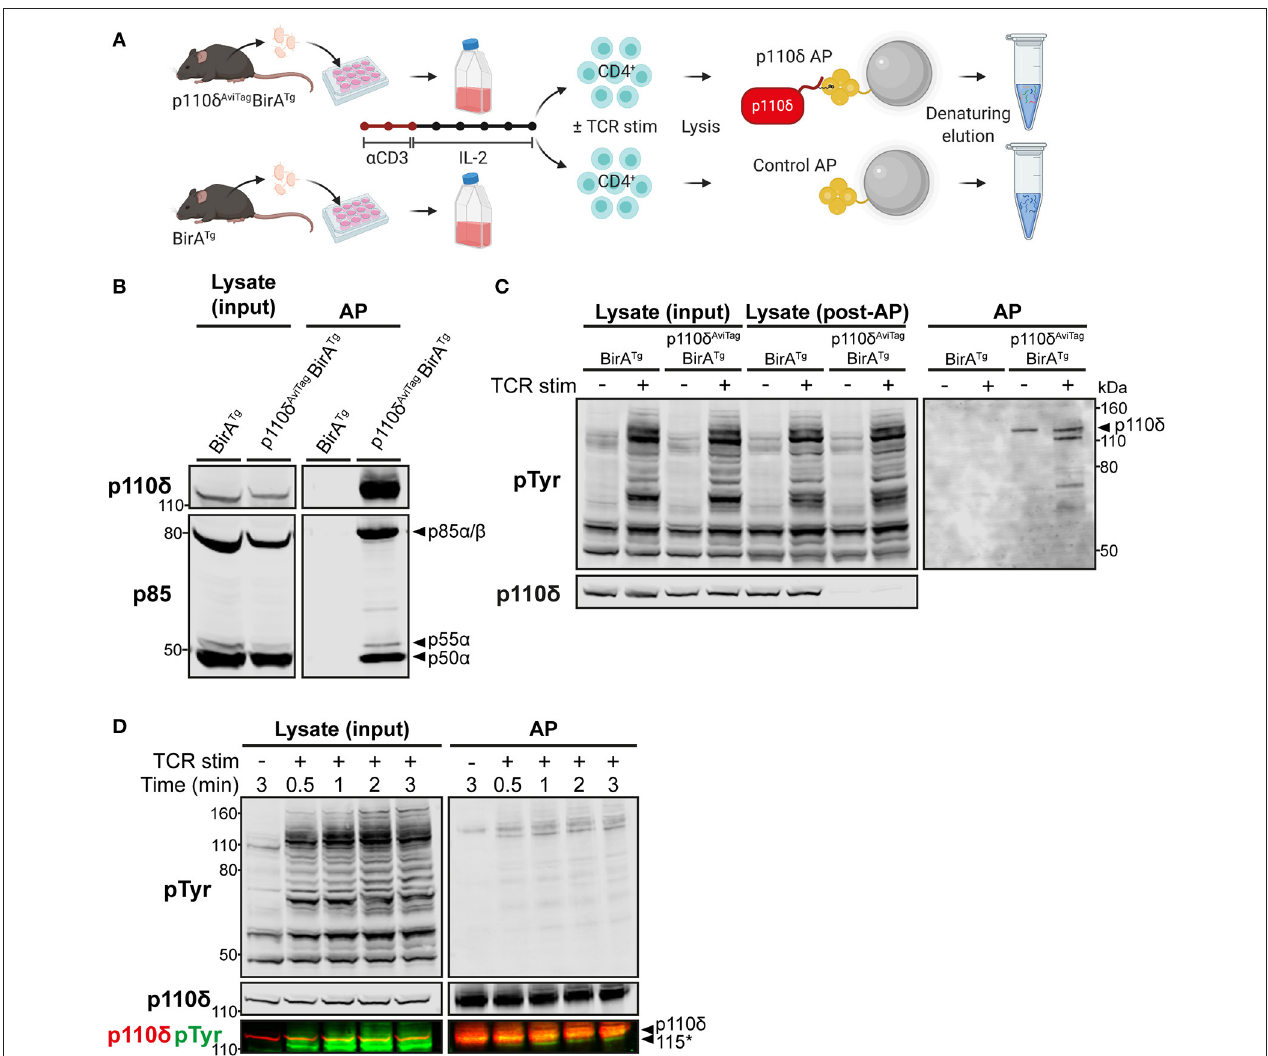
FIGURE 1 | Specific affinity purification of p110 δ complexes from primary CD4 + T cell blasts. (A) Schematic of the affinity purification (AP) protocol. T cells from the lymph nodes of p110 δ AviTag BirA Tg and BirA Tg (control) mice were activated in vitro with anti-CD3 for 48h and expanded for 5 days with IL-2. Purified CD4 + T cell blasts were then stimulated by CD3-CD4-crosslinking and their cell lysates were subjected to affinity purification (AP) using streptavidin-conjugated magnetic beads, as described in Materials and Methods. Proteins were eluted from the beads by denaturation then subjected to SDS-PAGE, before immunoblotting or nLC-MS/MS analysis. Schematic created with BioRender.com. (B) Immunoblot of control and p110 δ APs from BirA Tg and p110 δ AviTag BirA Tg CD4 + T cell blasts, respectively, alongside the whole cell lysate inputs. The membrane was probed with anti-p110 δ and anti-pan-p85, which detects all isoforms of p85. Immunoblot from one experiment representative of at least three independent experiments. (C) Immunoblot of control and p110 δ APs from BirA Tg and p110 δ AviTag BirA Tg CD4 + T cell blasts, respectively, that had been stimulated for 1min by CD3-CD4-crosslinking (TCR stim; + ) or were left unstimulated (–), alongside whole cell lysates before (input) and after (post-AP) affinity purification to show efficient depletion of p110 δ . Membranes were probed with anti-phosphotyrosine (pTyr), to detect phosphorylated tyrosine residues, and anti-p110 δ . The black arrowhead indicates p110 δ (119.7 kDa). Immunoblot from one experiment representative of at least three independent experiments. (D) Immunoblot of p110 δ APs and whole cell lysates from p110 δ AviTag BirA Tg CD4 + T cell blasts that had been stimulated for the indicated times by CD3-CD4-crosslinking (TCR stim; + ). Bands detected by anti-p110 δ and anti-pTyr are overlaid in the bottom panel to show that the unknown co-purified pTyr-protein of ∼ 115 kDa (labelled 115*) runs below p110 δ (119.7 kDa). Immunoblot from one experiment representative of two independent